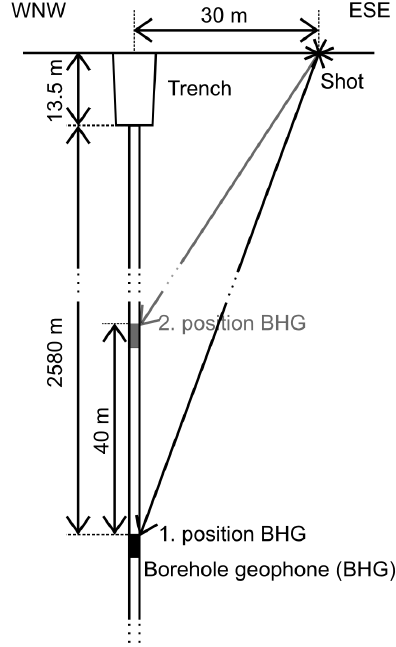
Figure 3. Geometry for shooting of VSP survey. The shot location was 30m away from the borehole location. The borehole geophone (BHG) was pulled up in intervals of 40m from a depth of 2580 to 60m depth for the detonation cord as the source. The survey was complemented between 2560 and 1600m, with boosters as the source and locations of the borehole geophone shifted by 20m to the previous survey, likewise in 40m intervals. The depth is given to the top of the borehole casing, measured to be 13.5m below the surface (January